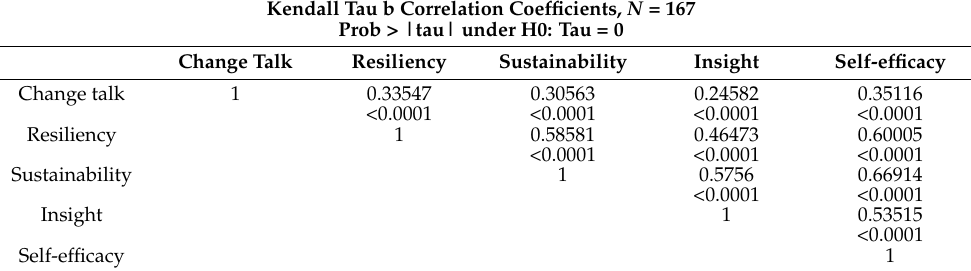
Table 3. Correlation Matrix of Measures.